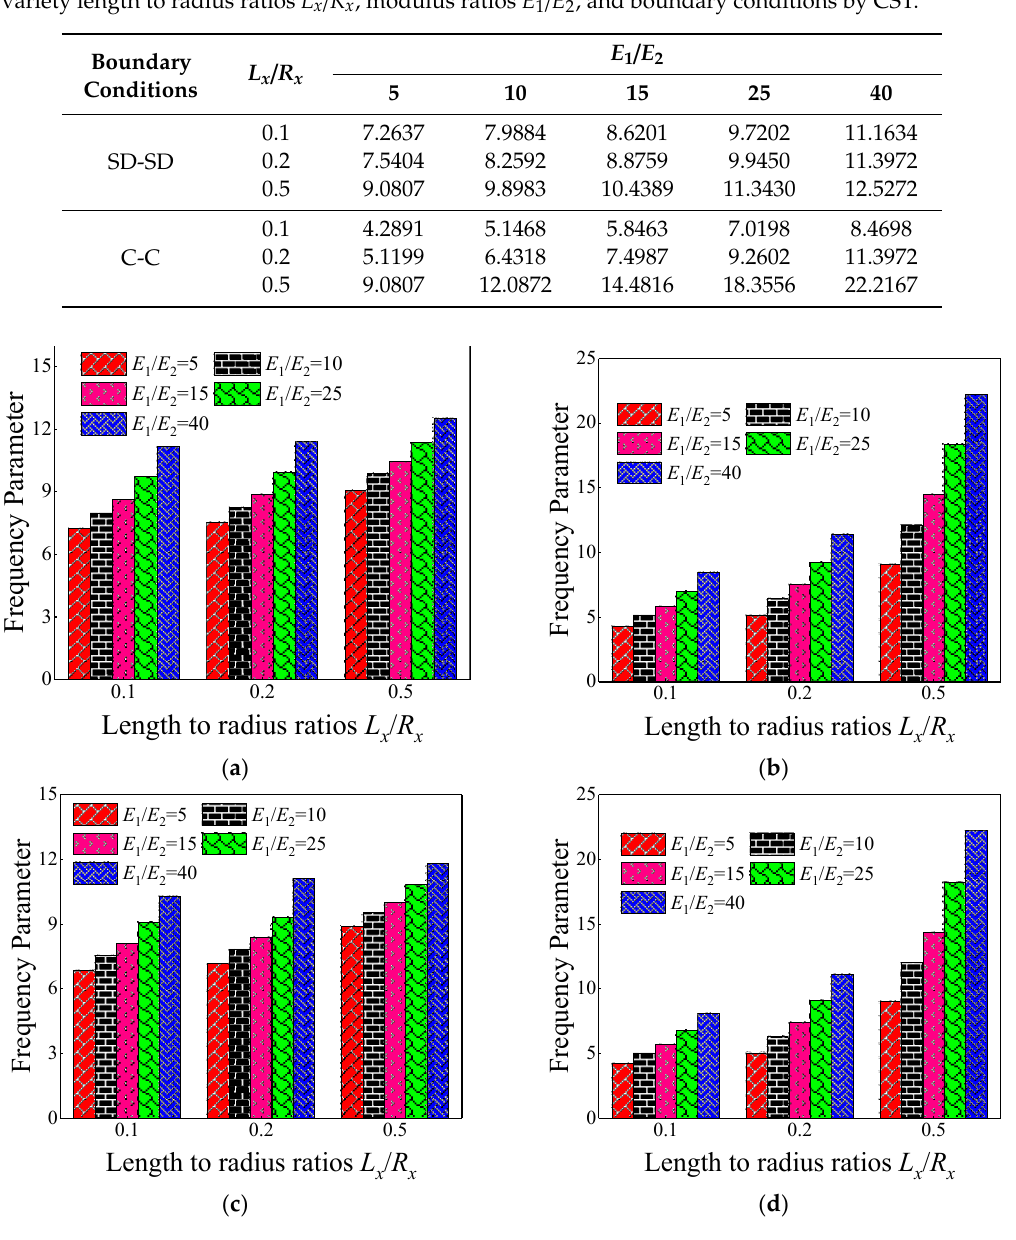
Figure 6. Variation laws of the fundamental frequency parameter Ω for composite laminated shallow spherical shells with various boundary conditions with respect to diverse length to radius ratios L x / R x and modulus ratios E 1 /E 2 by FSDT and CST. ( a ) FSDT: SD-SD; ( b ) FSDT: C-C; ( c ) CST: SD-SD; ( d ) CST: C-C.